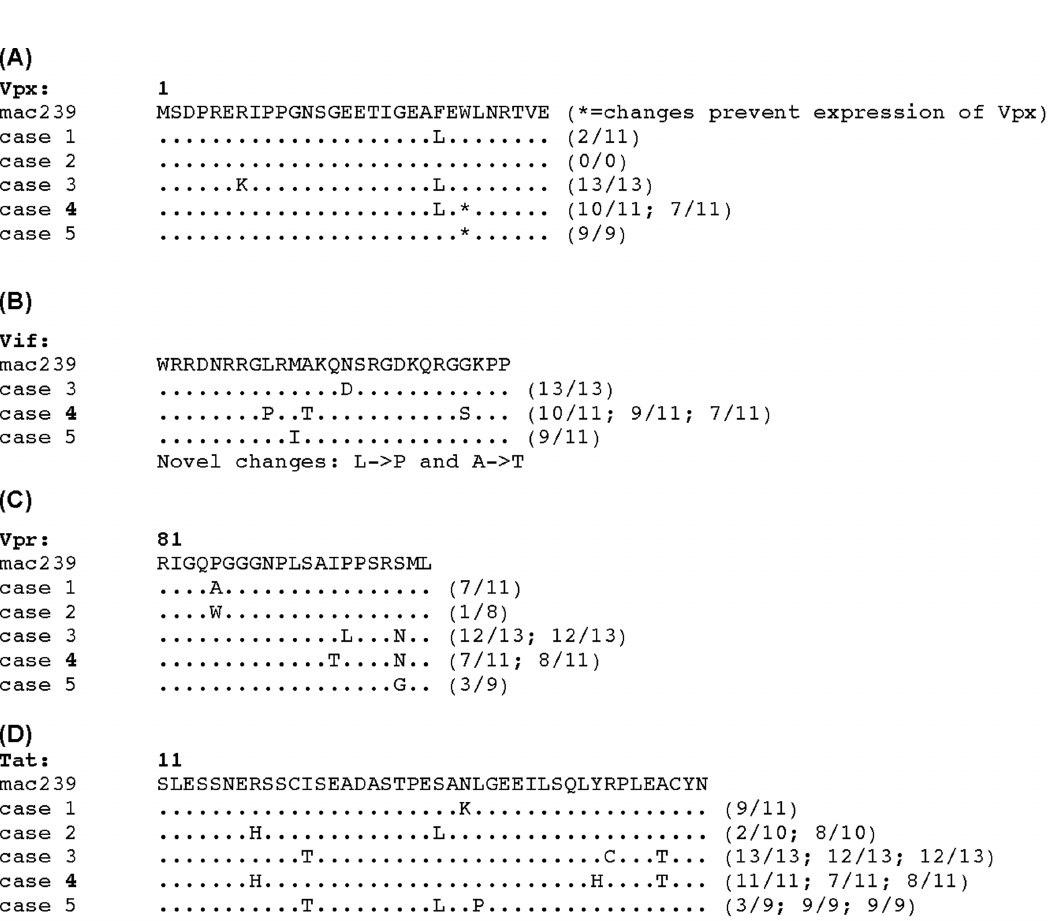
Figure 2. Amino acid sequences from chronic infection plasma viral RNA from SIV D vpx -infected monkeys. (A). Vpx N-terminal sequences accumulated debilitating mutations in two animals (cases 4 and 5) (*). (B). Novel amino acid sequence changes of Vif were present in case 4 (with highest viral loads) with leucine to proline (L- . P) and alanine to threonine (A- . T). (C). Analysis of Vpr revealed changes in amino acid sequences detected at the C-terminal region in cases 3 and 4 (I94T, P95L, S99N or G). (D). Alignments of Tat demonstrated multiple non-conservative changes, such as I22T, S32L, L35P.